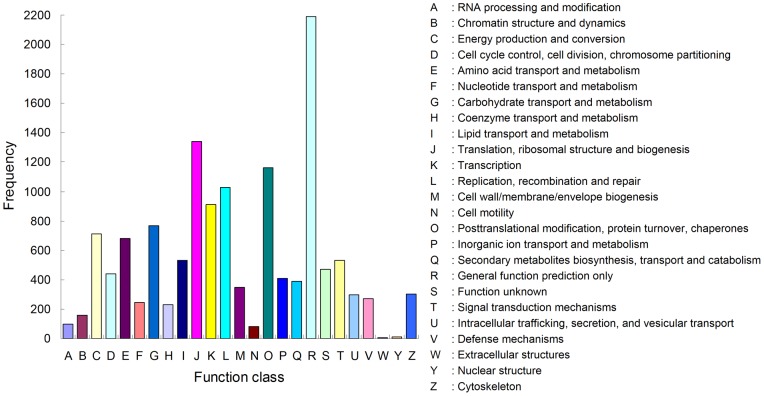
Clusters of orthologous groups (COG) classification of Tenebrio molitor unigenes.A total of 13,599 produced functional annotations were among the 25 categories.